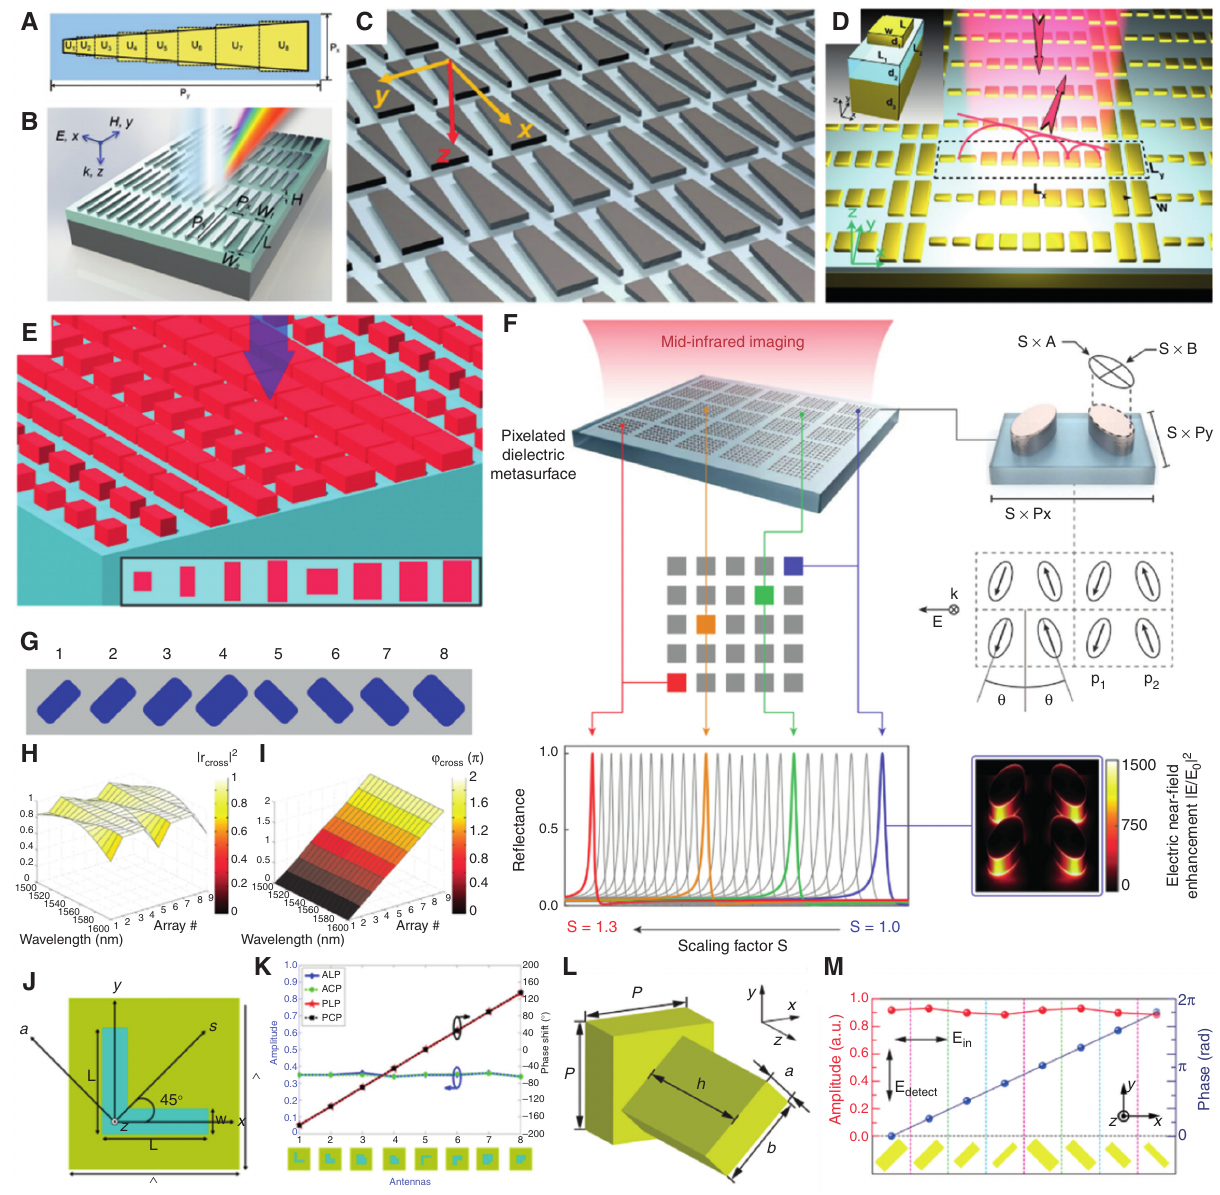
Figure 5: Anisotropic nanostructures with varied dimensions. (A–C) Trapezoidal nanostructures [40–42]. (D and E) Cuboid nanostructures [43, 44]. (F) Spectrometer composed of high-Q nanostructures enabled with Mie resonance [45]. (G–I) Cuboid nanostructures with both phase control and polarization conversion functionalities in the IR band and the simulated cross-polarized reflectivity and phase delays [46]. (J and K) L-shaped nanostructures with both phase control and polarization conversion functionalities and the simulation results [47]. (L and M) Nanofins with phase control and polarization conversion functionalities and the simulation results in the THz band [48]. Reprint permission obtained from